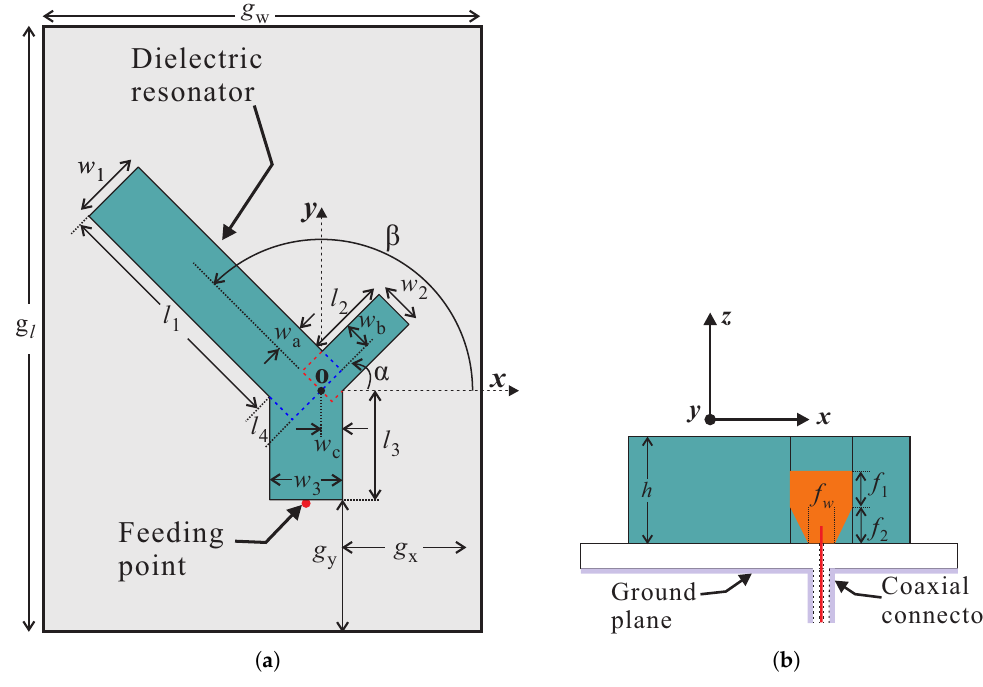
Figure 1. Geometry of the proposed antenna: ( a ) Top view; ( b ) Side